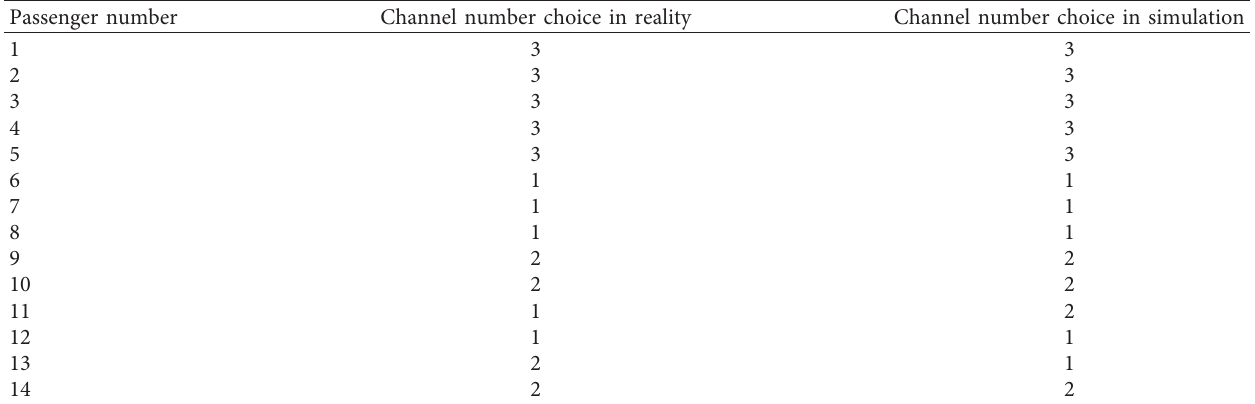
Table 5: Comparison of passengers’ choices in reality and